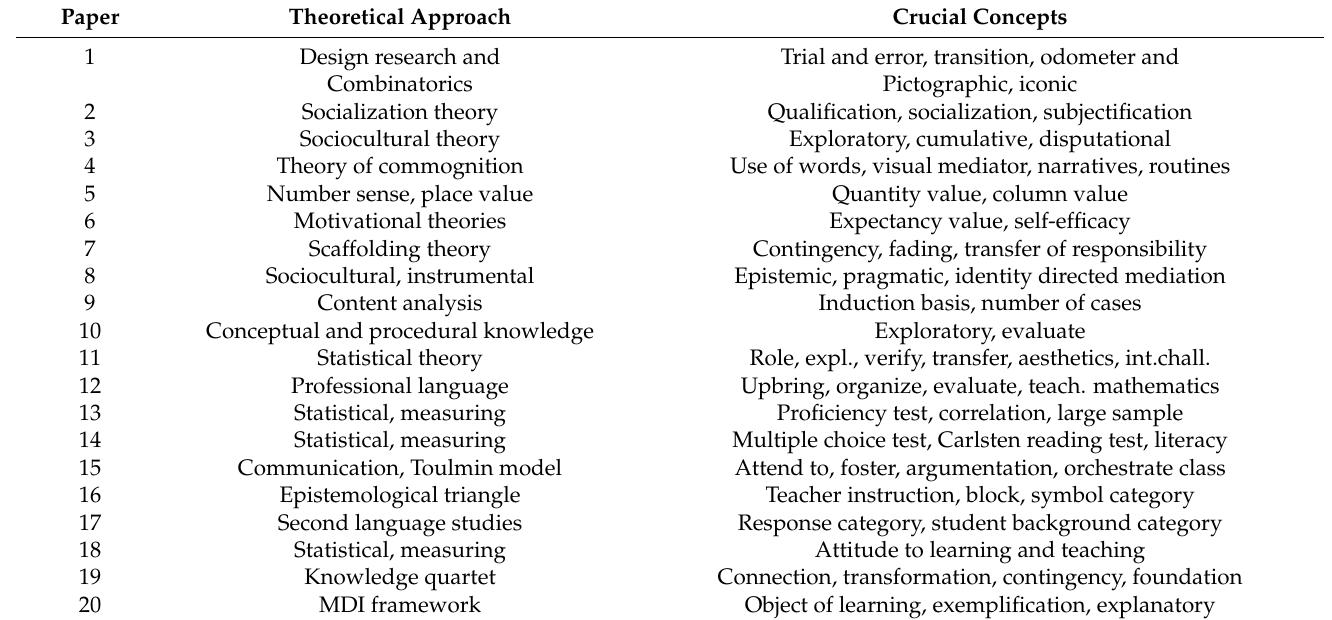
Table 5. Theoretical approach and crucial concepts used for the 20 first papers in NORMA17.